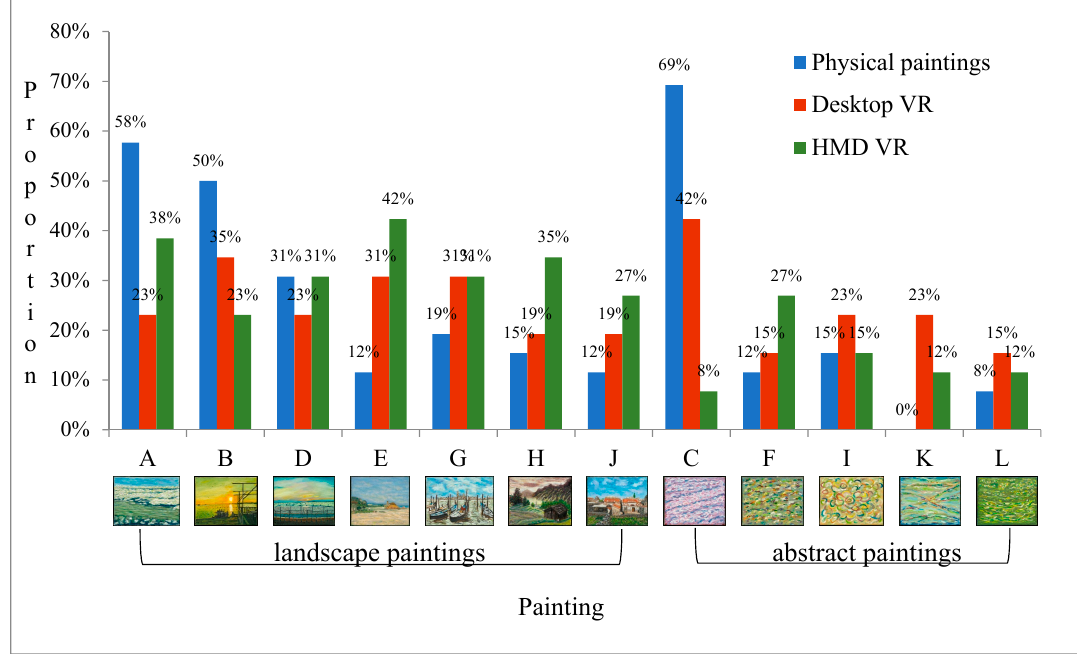
Figure 6. Proportion of each painting being selected as a favorite.